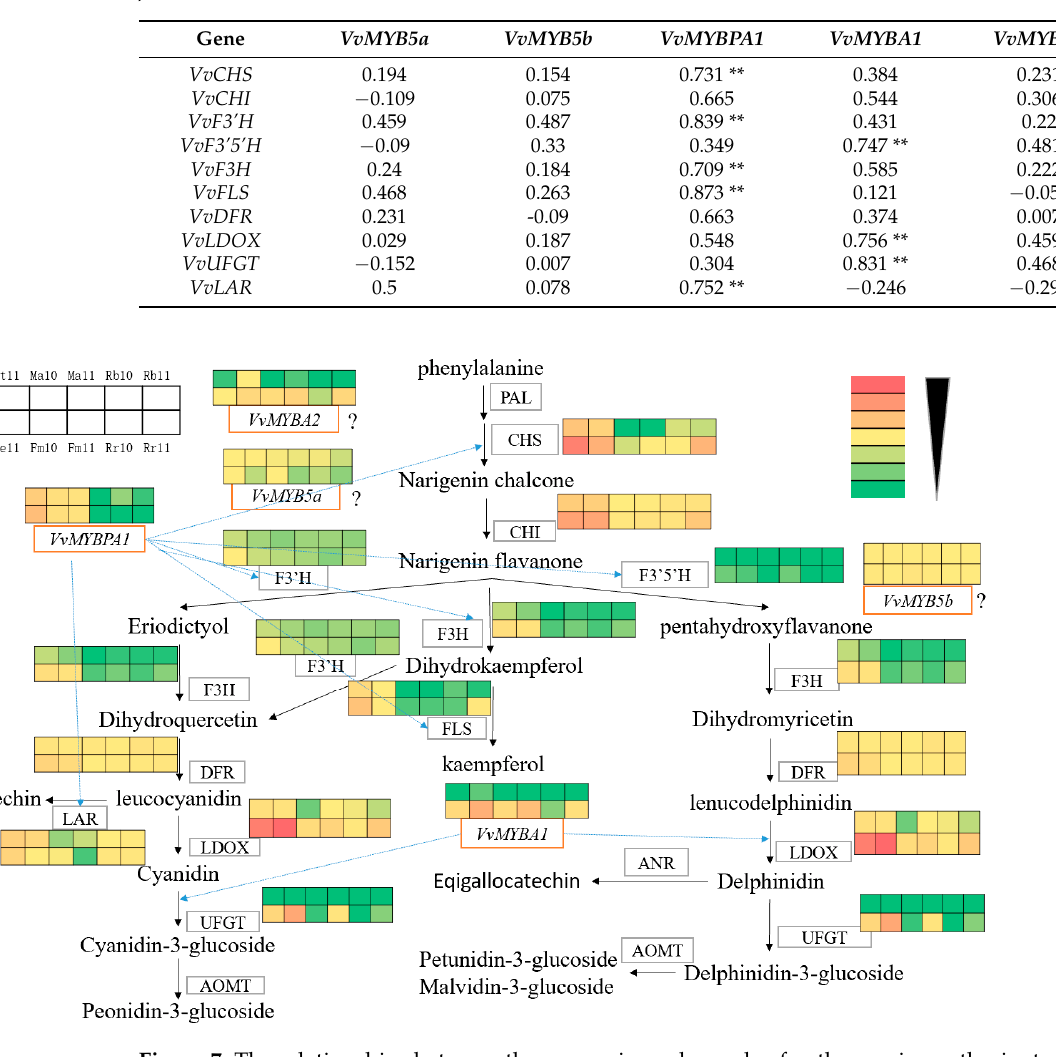
Table 3. MYB-related regulatory genes related to anthocyanin synthesis structural genes. ** repre- sents p < 0.01.